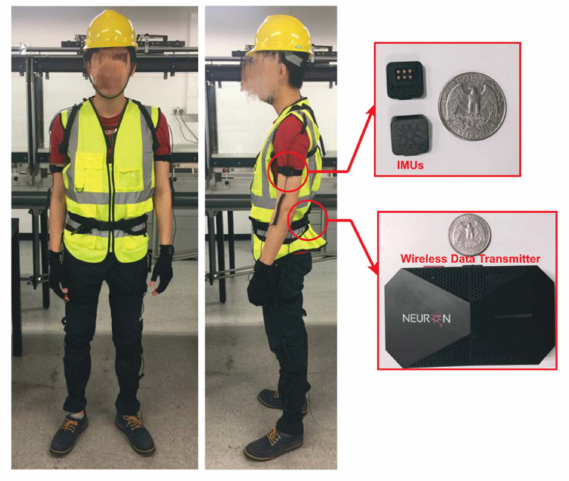
Figure 10. IMU-based wearable motion capture system (Perception Neuron)